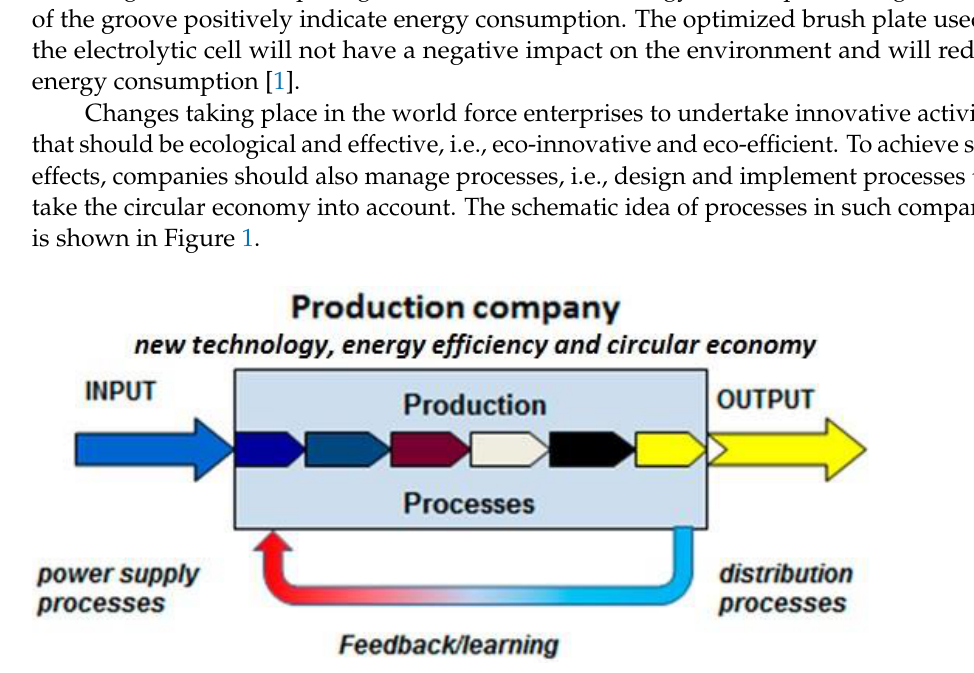
Figure 1. The schematic idea of processes in the company [2].